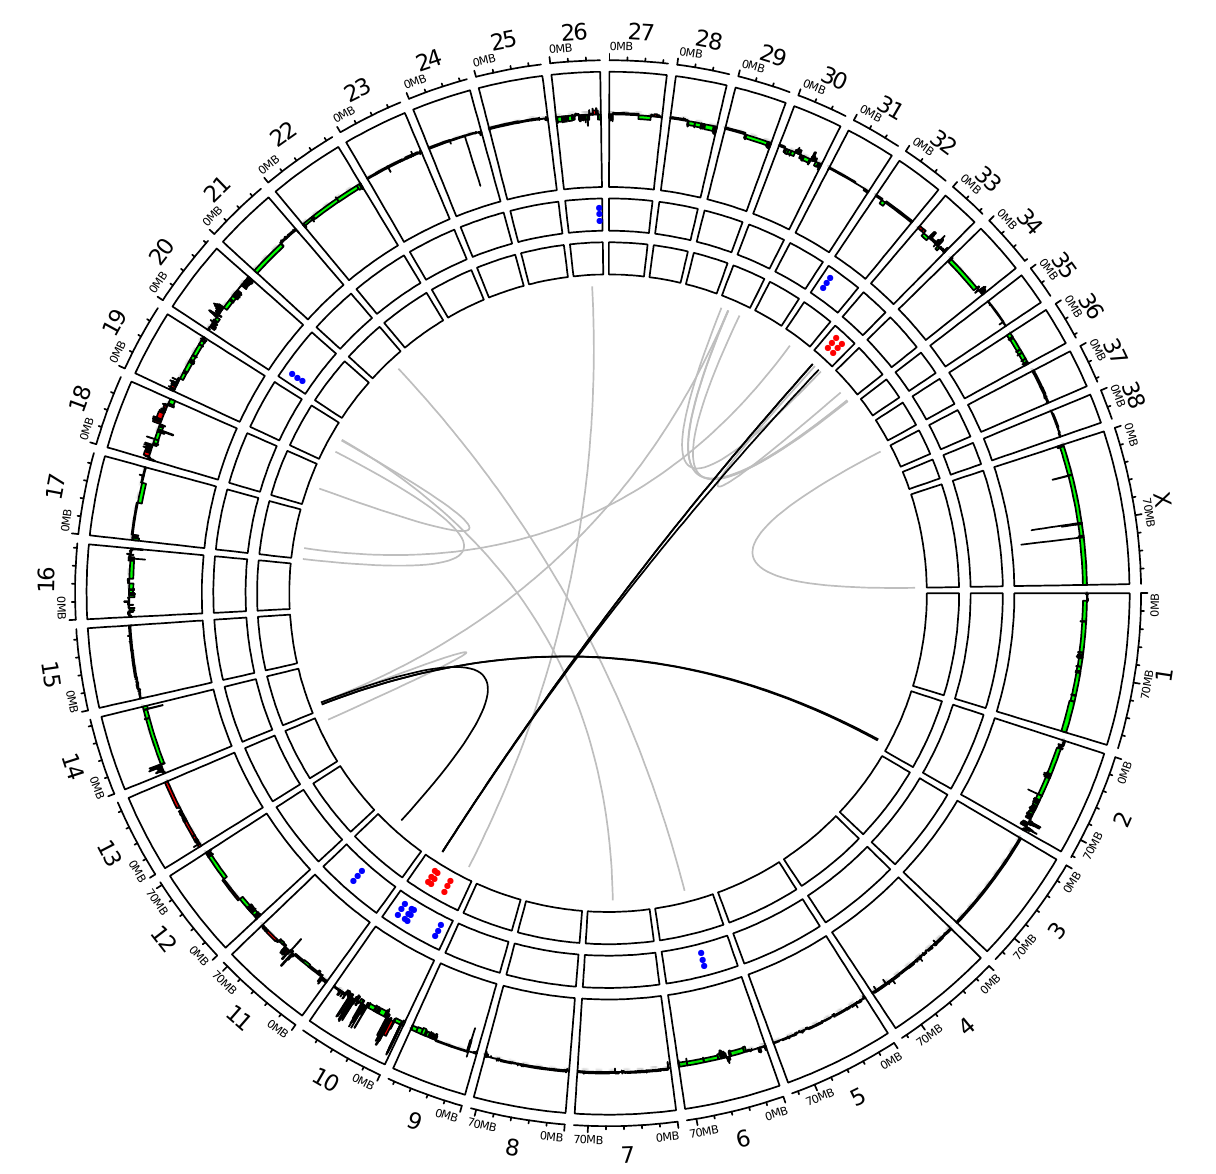
Figure A5. Circos plot representing the distribution of SVs of Dog-OralMel-18395 cell line along dog chromosomes with, from external to internal layers, CNA gains/losses (in dark red/green), deletions, duplications, insertions, and inversions in blue, light red, orange, and green, respectively. Interchromosomal break-ends (BND) are represented by gray lines connecting chromosomes with a color intensity corresponding to the number of reads validating the SV.